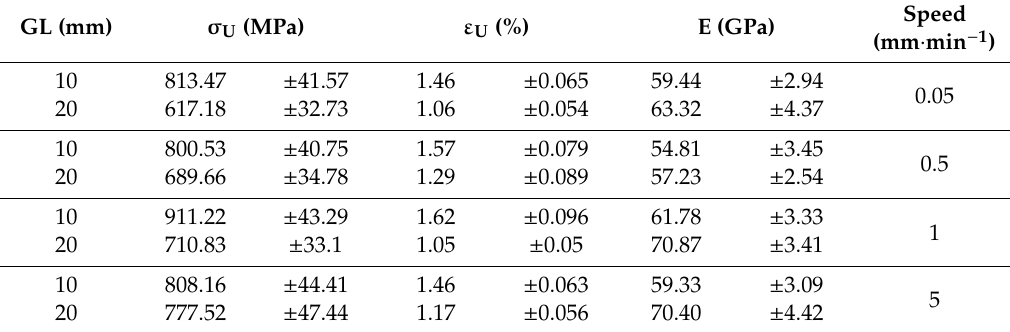
Table 1. Average values of mechanical properties of kenaf fibers at di ff erent cross-head speeds.